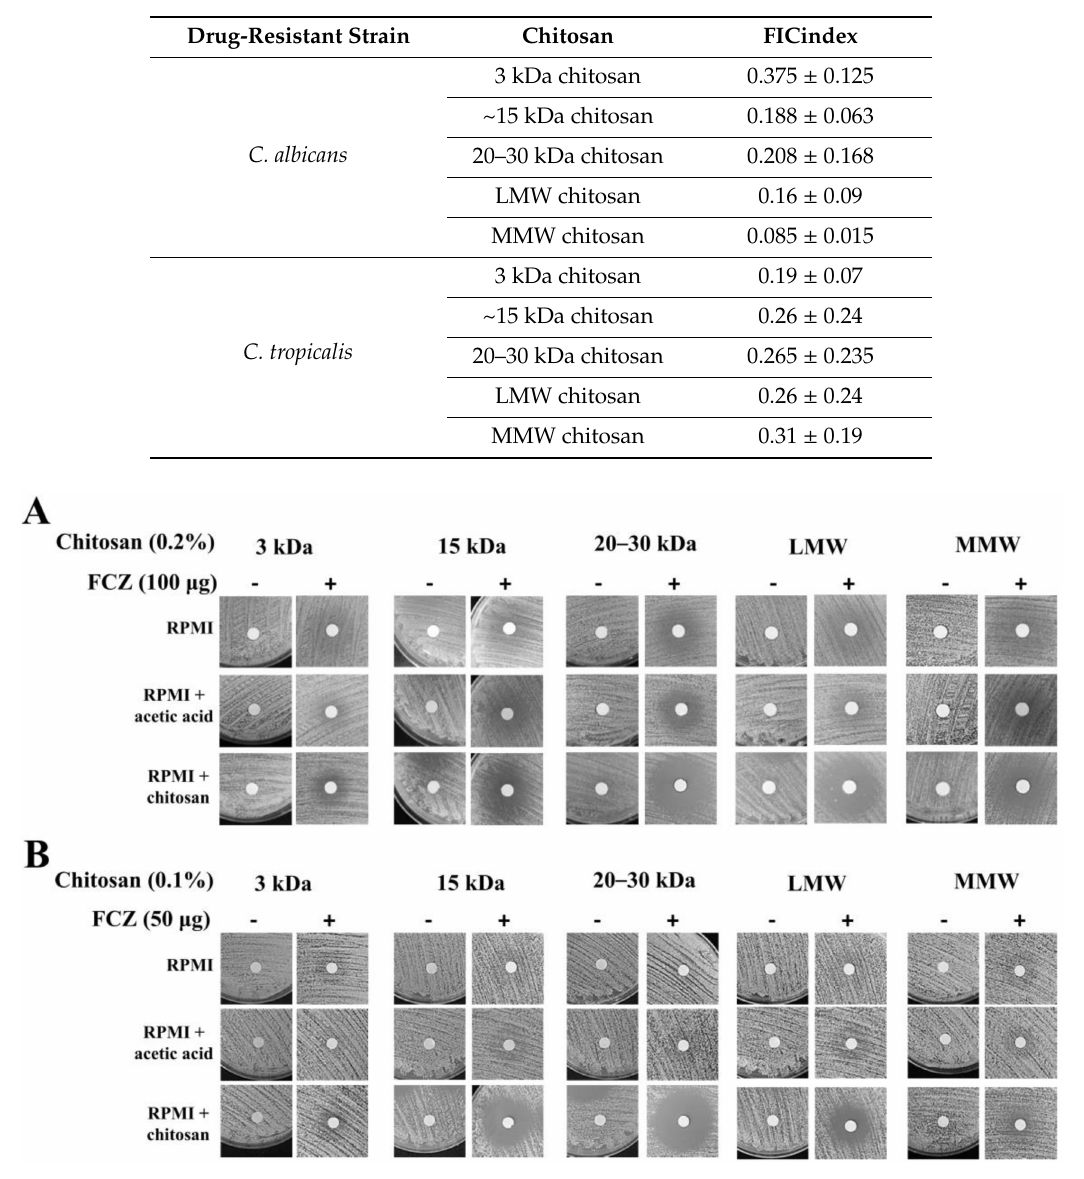
Figure 3. Disk di ff usion assay of each chitosan with or without fluconazole against drug-resistant Candida strains. Fluconazole-resistant strains of C. albicans and C. tropicalis were significantly inhibited after treatment the combination of chitosan and fluconazole, particularly 15 kDa, 20–35 kDa, and LMW